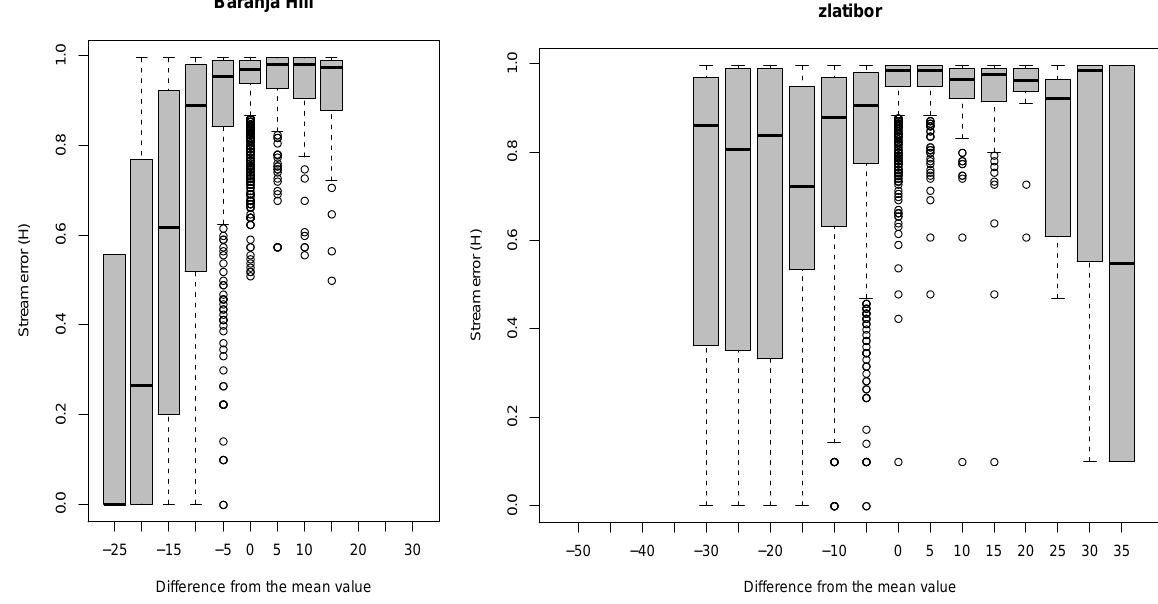
Fig. 7. Bar plots showing relationship between the relative relief (difference from the mean value in the 5 × 5 search radius) and cumulative errors. In both cases the highest errors of mapping streams are in slightly convex areas (positive values in range